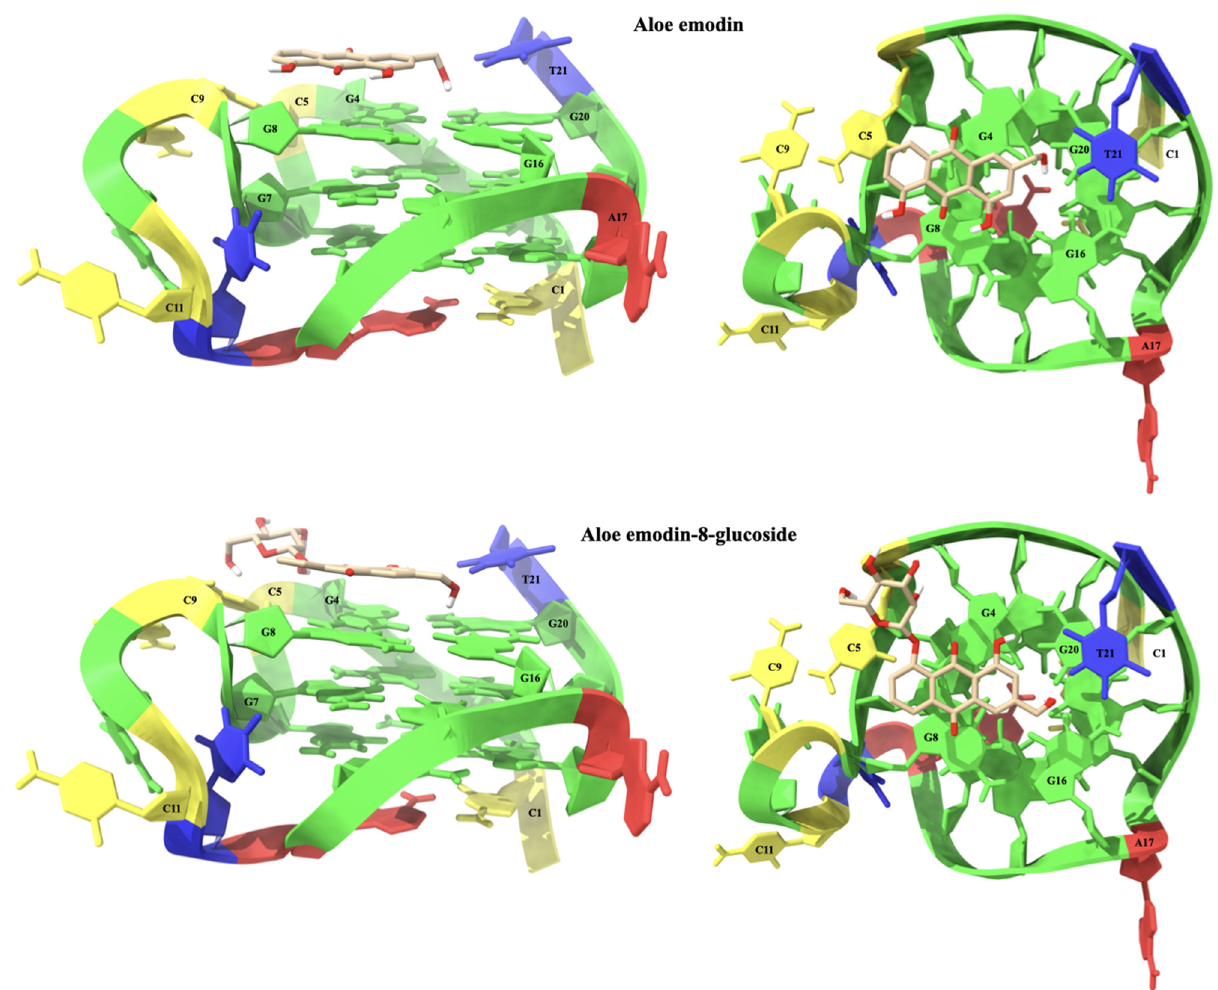
Figure 8. Lateral ( left ) and top ( right ) views of the aloe emodin ( 1 ) and aloe emodin ‐ 8 ‐ glucoside ( 2 ) complexes with the C ‐ Kit G ‐ quadruplex sequence. The nucleotides are shown as slabs and filled sugars: Adenine in red, cytosine in yellow, guanine in green, and thymine in blue. Labels are added to highlight key nucleotides. The ligand molecules are rendered in sticks and colored according to the atoms and only polar hydrogens are shown.